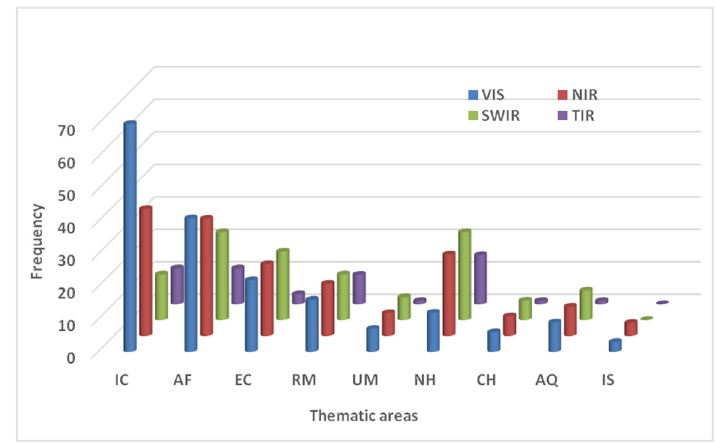
Figure 9. Spectral ranges, namely Visible (VIS), Near Infrared (NIR), Shortwave Infrared (SWIR), and Thermal Infrared (TIR), covered by the available layers (hyperspectral-based products and services), distinguished by thematic area, as a result of the interaction with the user communities. The frequency reported refers to the number of times a particular spectral range is present in a layer that achieves a user need.